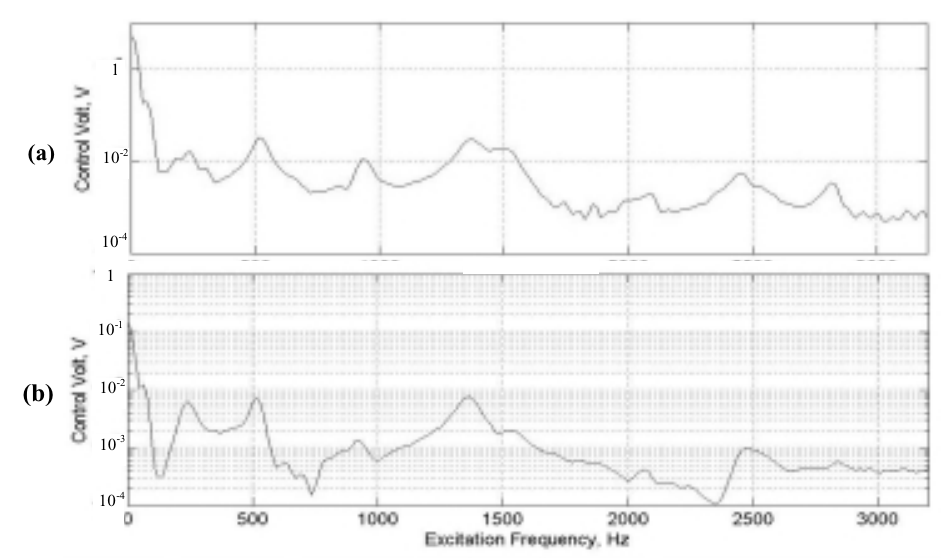
Fig. 11. The control voltage of: (a) the lower actuator, and (b) the upper